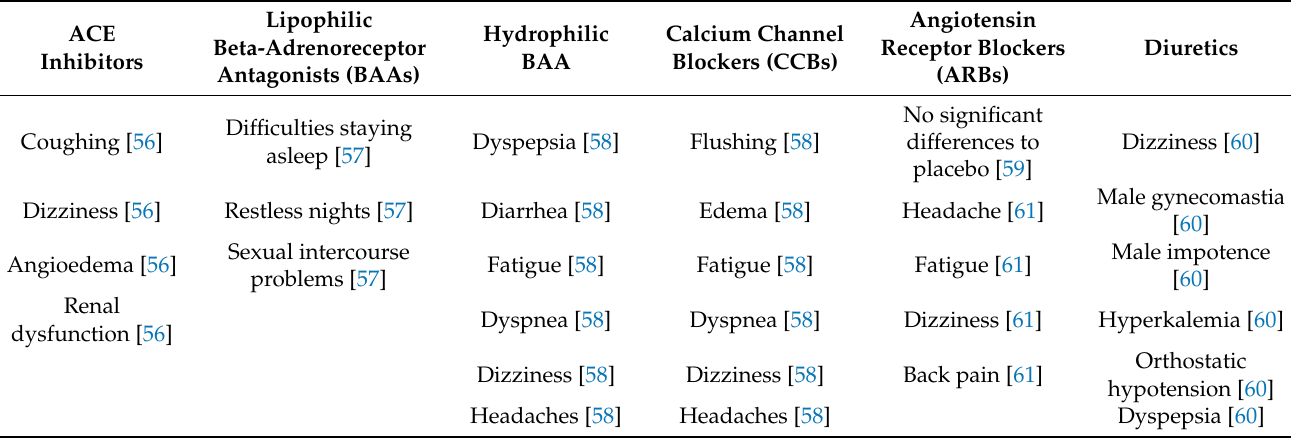
Table 4. Examples of AEs of the five major classes of antihypertensive medication